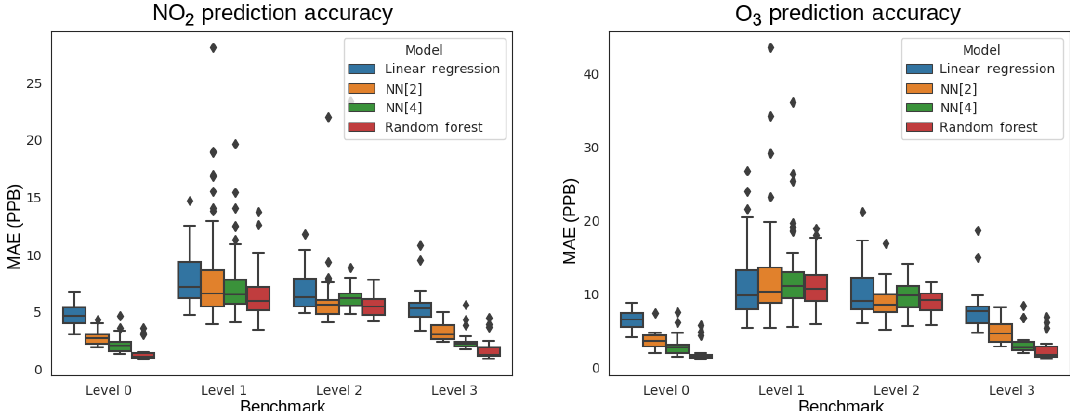
Figure 6. Mean absolute error (MAE) boxplots for NO 2 and O 3 , for the Level 0 through Level 3